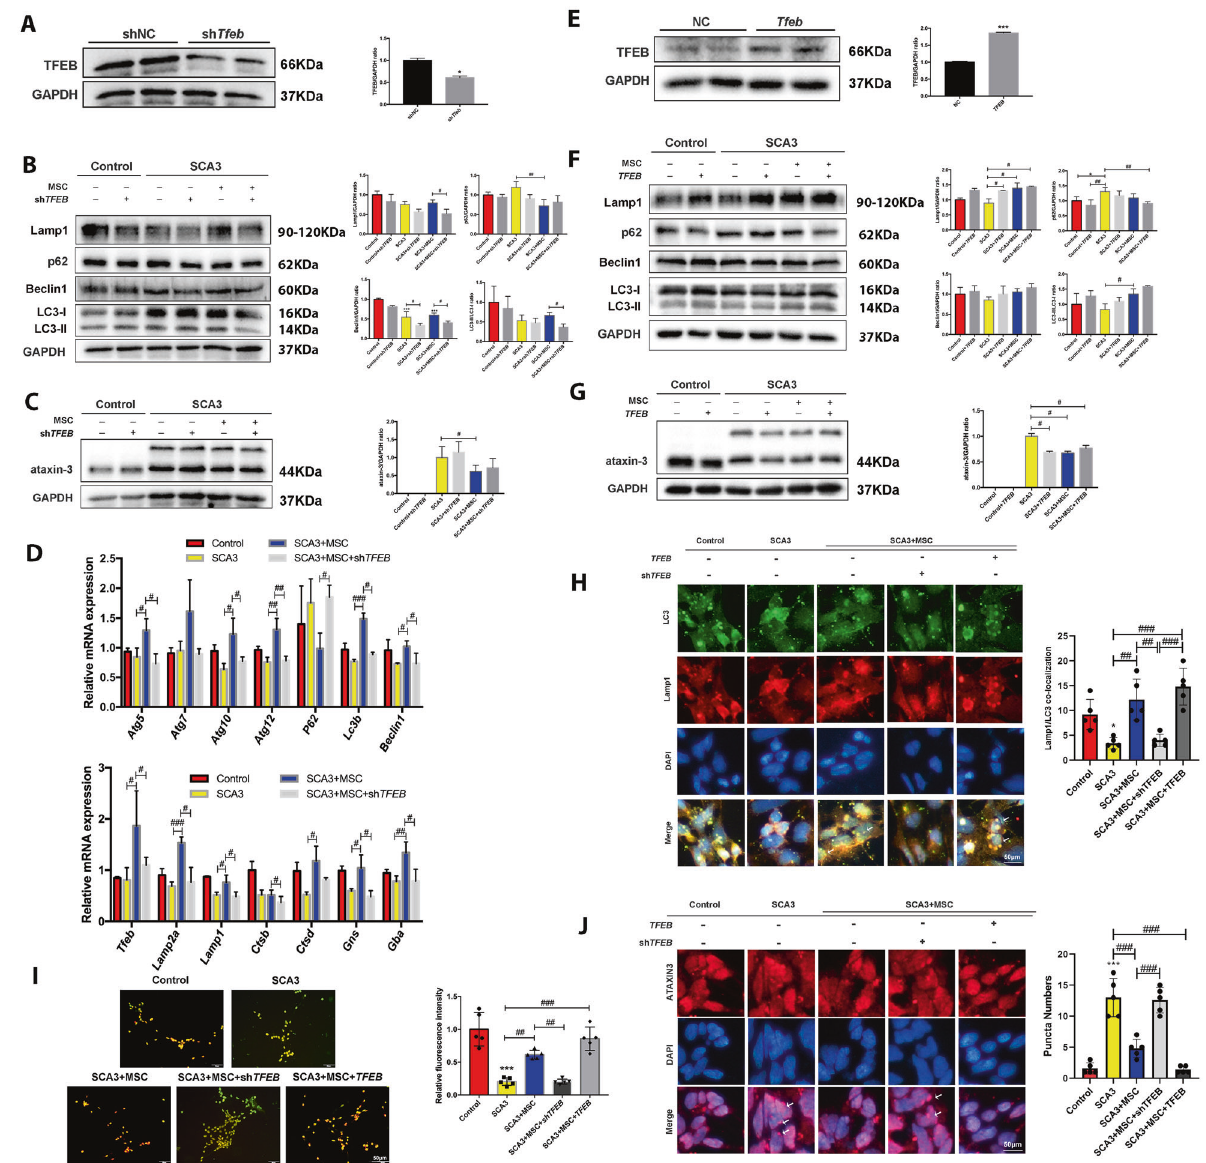
Fig. 4 MSCs co-culture activated autophagolysosome and alleviated mutant ataxin-3 protein-dependent on TFEB nuclear translocation in SCA3 neurons. A The expression of TFEB after adding Lentiviral shTFEB plasmid. B The effects of shTFEB on the expression of p62, Beclin1, LC3, and lamp1 after MSCs therapy. C The effects of shTFEB on the expression of mutant ataxin-3 after MSCs therapy. D The mRNA expression of autophagy and lysosome-related genes. E The expression of TFEB after adding Lentiviral TFEB plasmid. F The effects of TFEB on the expression of p62, Beclin1, LC3, and lamp1 after MSCs therapy. G The effects of TFEB on the expression of mutant ataxin-3 after MSCs therapy. H LC3 and Lamp1 co-localization after shTFEB and TFEB by immuno fl uorescence (scale bar: 50 μ m). I The effects of shTFEB and TFEB on the acidic vesicles after MSCs treatment (scale bar: 50 μ m). J DAPI and mutant ataxin-3 co-localization after shTFEB and TFEB by immuno fl uorescence (scale bar: 50 μ m). * p < 0.05, *** p < 0.001 vs Control group, # p < 0.05, ## p < 0.01 , ### p <